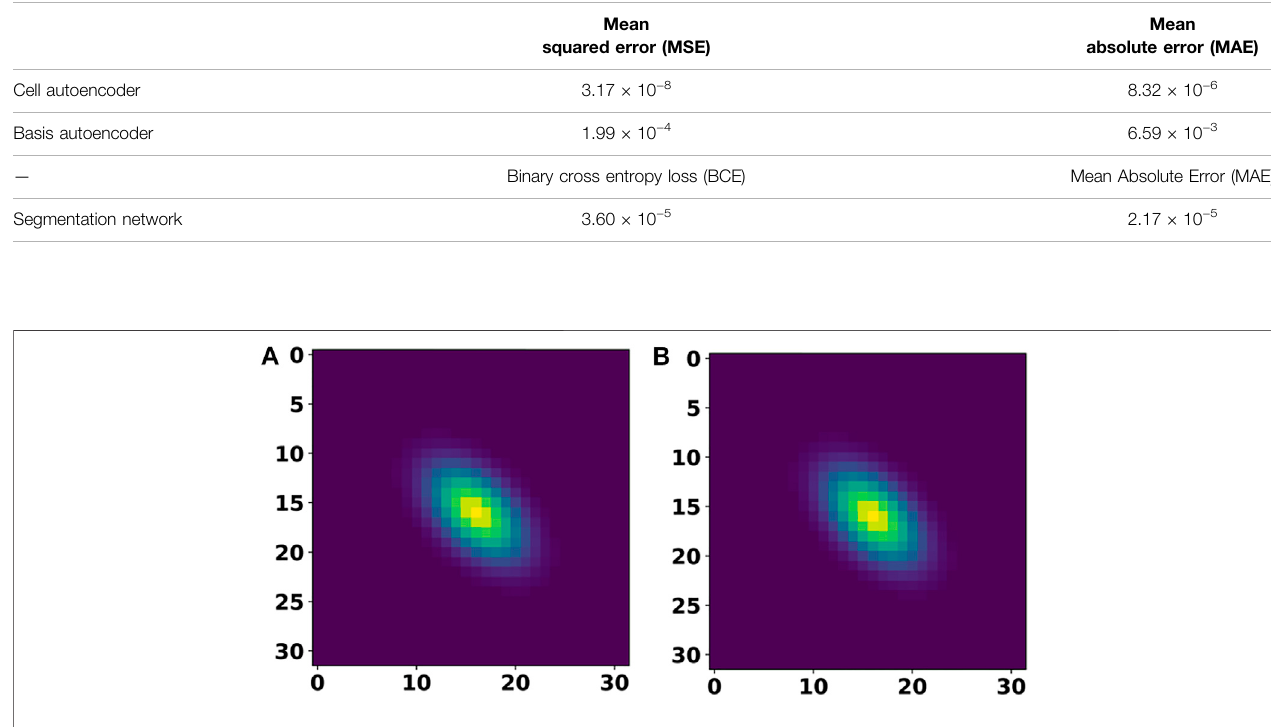
FIGURE 5 | A 2D slice of the input cell image (A) and its comparison with the corresponding 2D slice from the reconstructed (output of cell autoencoder) cell image (B) .